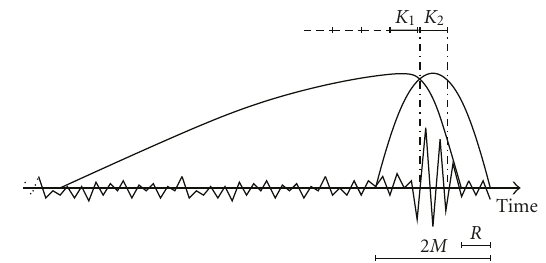
Figure 16: Stationarity detection applied to the analysis system with frame advance R and short windows of length 2 M = 4 R . In the example, the analysis window is switched from long asymmetric to short symmetric. Block 2 consists of K 2 = R samples. Block 1 has initially length K 1 = K 2 but grows by R samples as long as no nonstationarity is detected and until an upper limit for the length is reached.